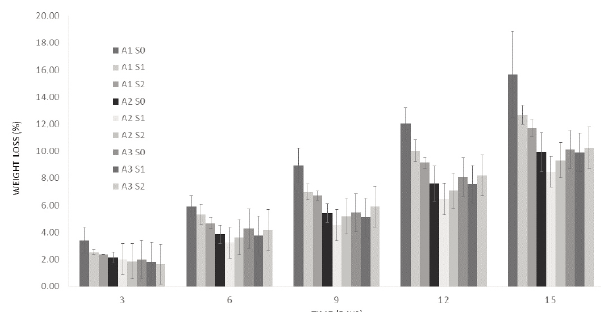
Fig. 1 - Effect of alginate based edible coating-betel essential oil on weight loss of rose-apple cv. Dalhari.